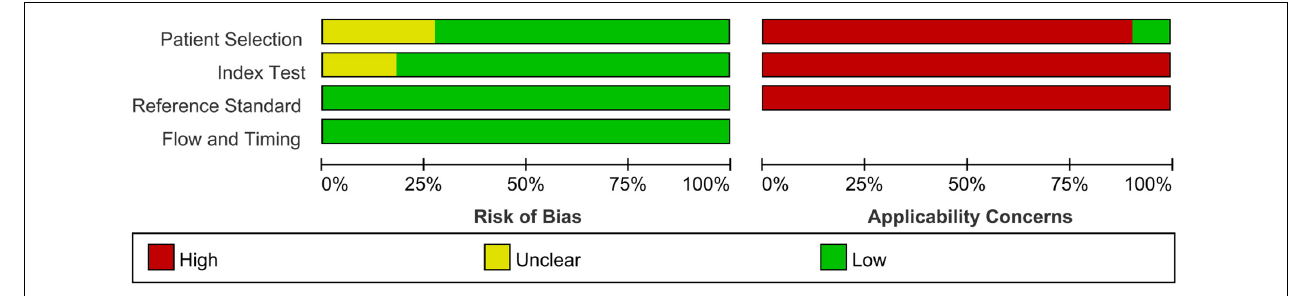
FIGURE 3 | Summary of quality assessment.